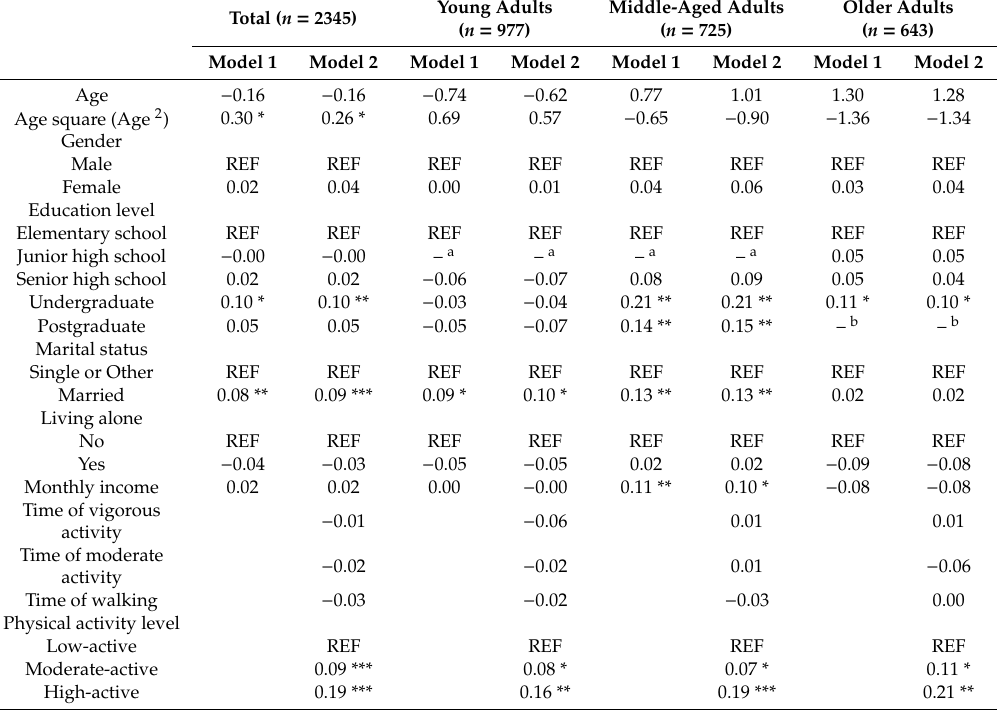
Table 3. Summary of regression analyses: demographic characteristics, physical activity, and